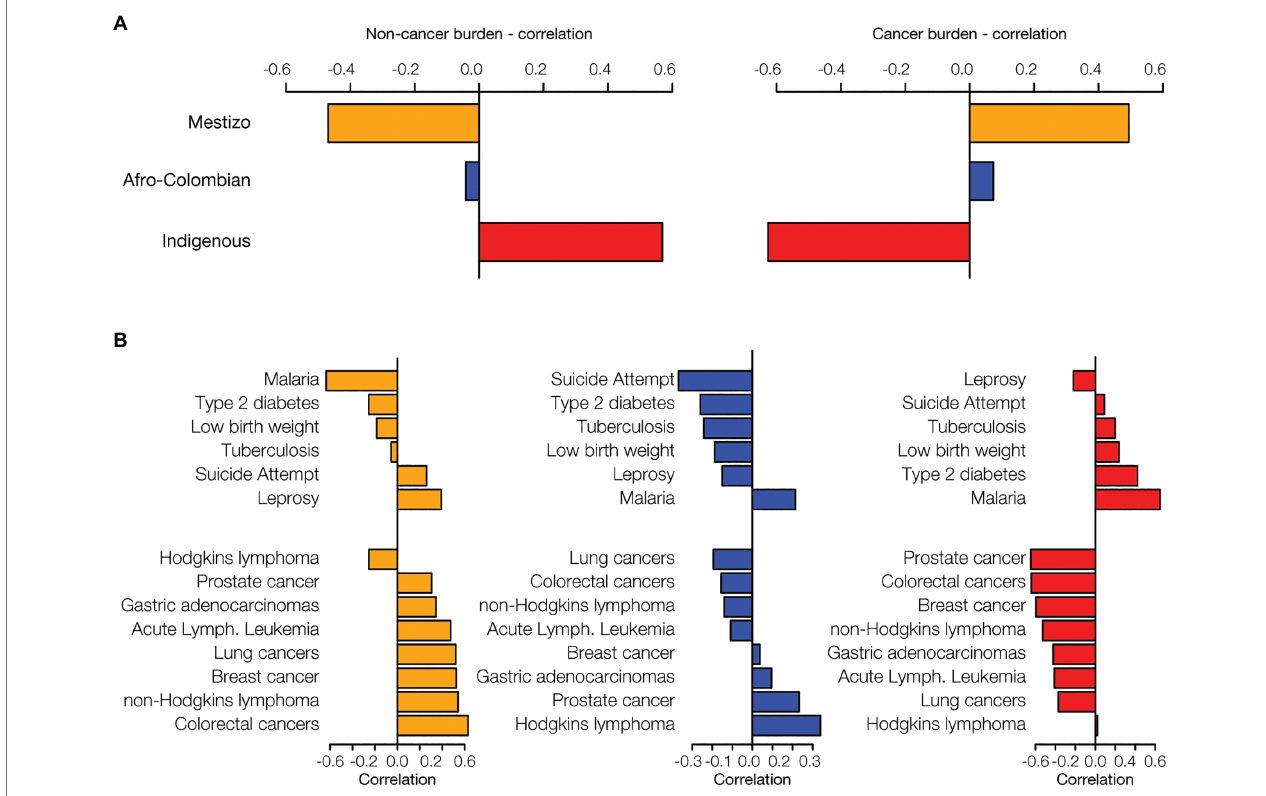
FIGURE 3 | Ethnicity and disease prevalence. Administrative department ethnic group percentages were correlated with disease prevalence data. Data are shown for the three largest ethnic groups in Colombia: Mestizo (orange), Afro-Colombian (blue), and Indigenous (red). (A) The overall correlation of ethnicity with disease prevalence was calculated by summing the disease-specific correlations for six non-cancer health conditions and eight cancers. (B) For each ethnic group, ethnicity-disease prevalence correlations are shown for six non-cancer conditions (top of each plot) and the eight cancers (bottom of each